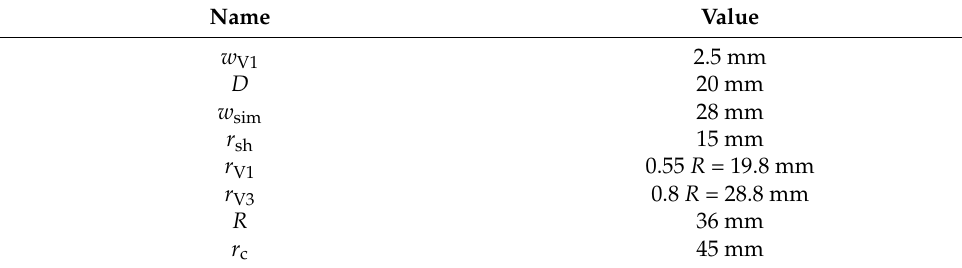
Table 2. Dimensions of the investigated volumes as drawn in Figure